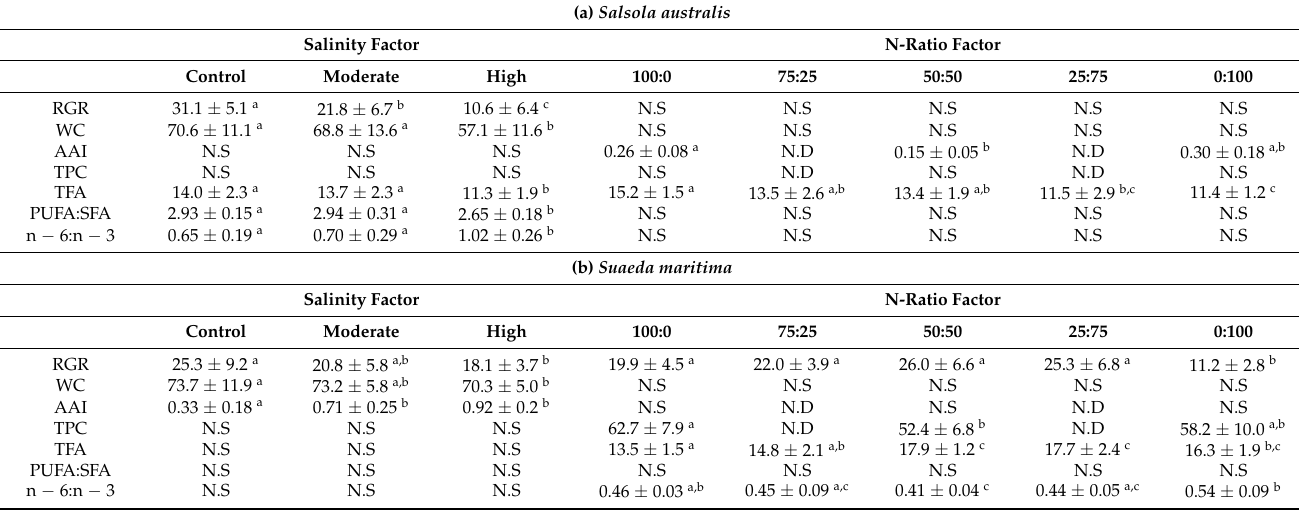
Table 3. Multiple comparisons of relative growth rate (RGR) (mg g − 1 day − 1 ), water content (WC) (% FW ), antioxidant activity index (AAI), total phenolic compounds (TPC) content (mg GAE g DW − 1 ), total fatty acid (TFA) content (mg g DW − 1 ), ratio of polyunsaturated on saturated fatty acids (PUFA:SFA) and ratio of omega 6 on omega 3 fatty acids (n − 6:n − 3) in (a) Salsola australis, (b) Suaeda maritima and (c) Enchylaena tomentosa according to salinities (control, moderate or high) and N-ratios (NO 3 − -N:NH 4+